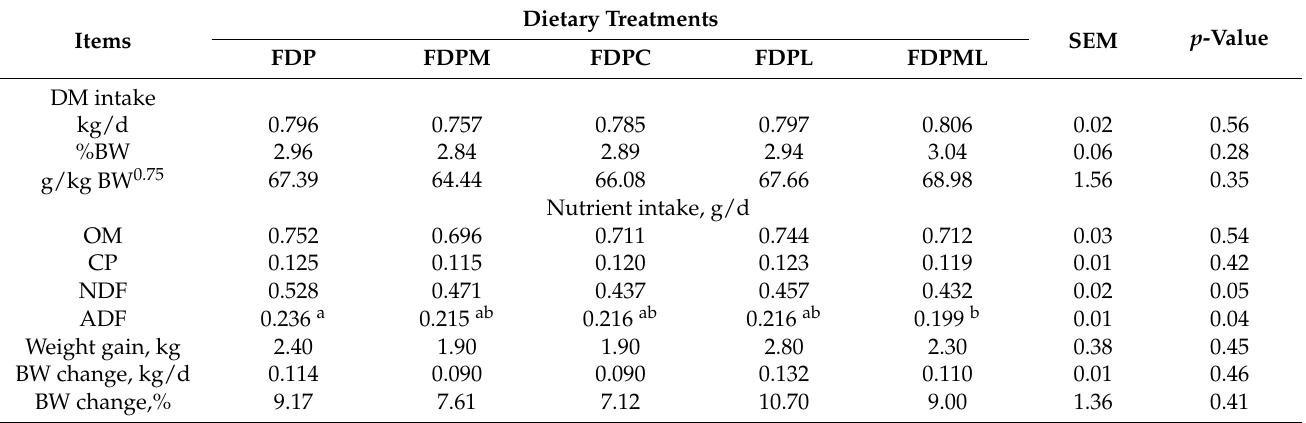
Table 2. Effects of untreated and treated discarded durian peel in TMR on intake and body weight change in growing